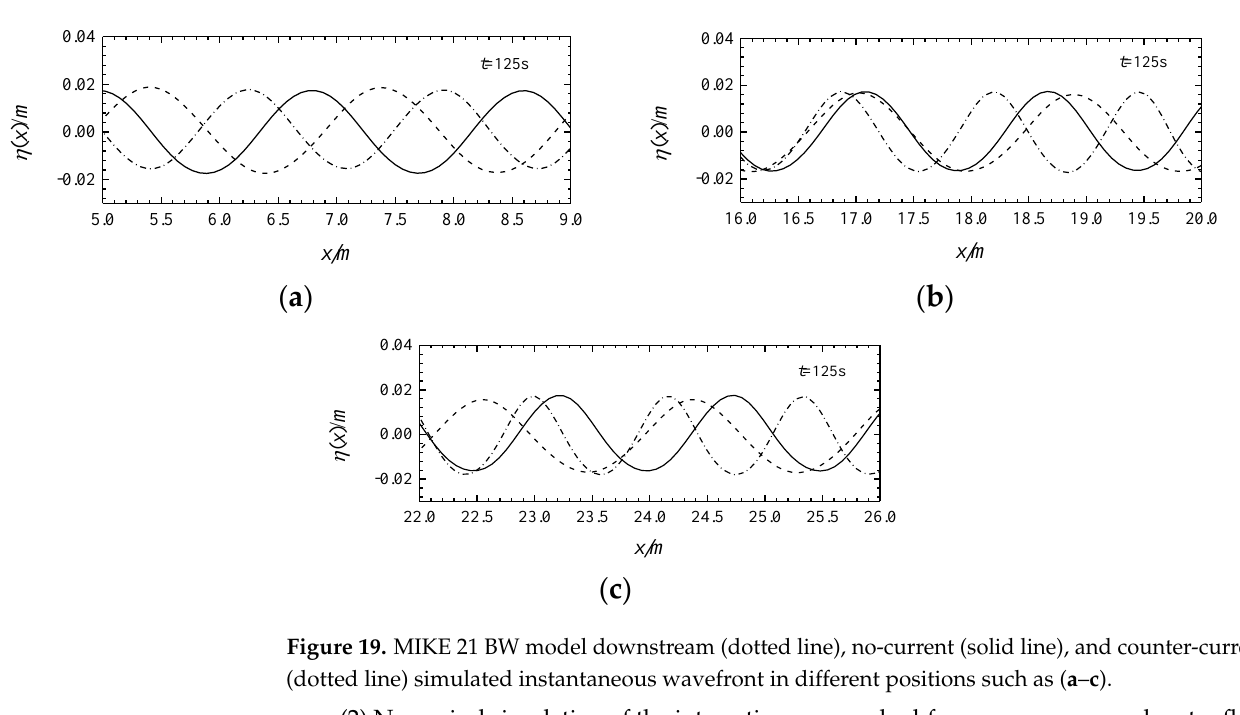
Figure 18. Comparison of wave surfaces at three points x = 7 m (a), 18 m (b), and 24 m (c) of downstream (dotted line), no-current (solid line), and counter-current (dotted line) of MIKE 21 BW model.